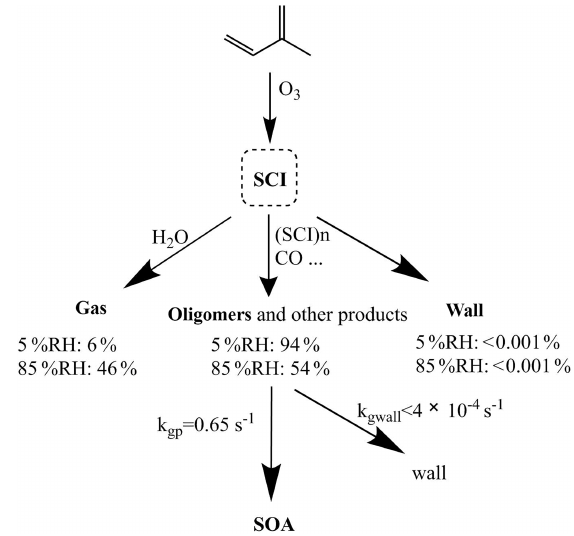
Figure 14. Wall losses vs. gas-phase reactions between H 2 O and SCIs.